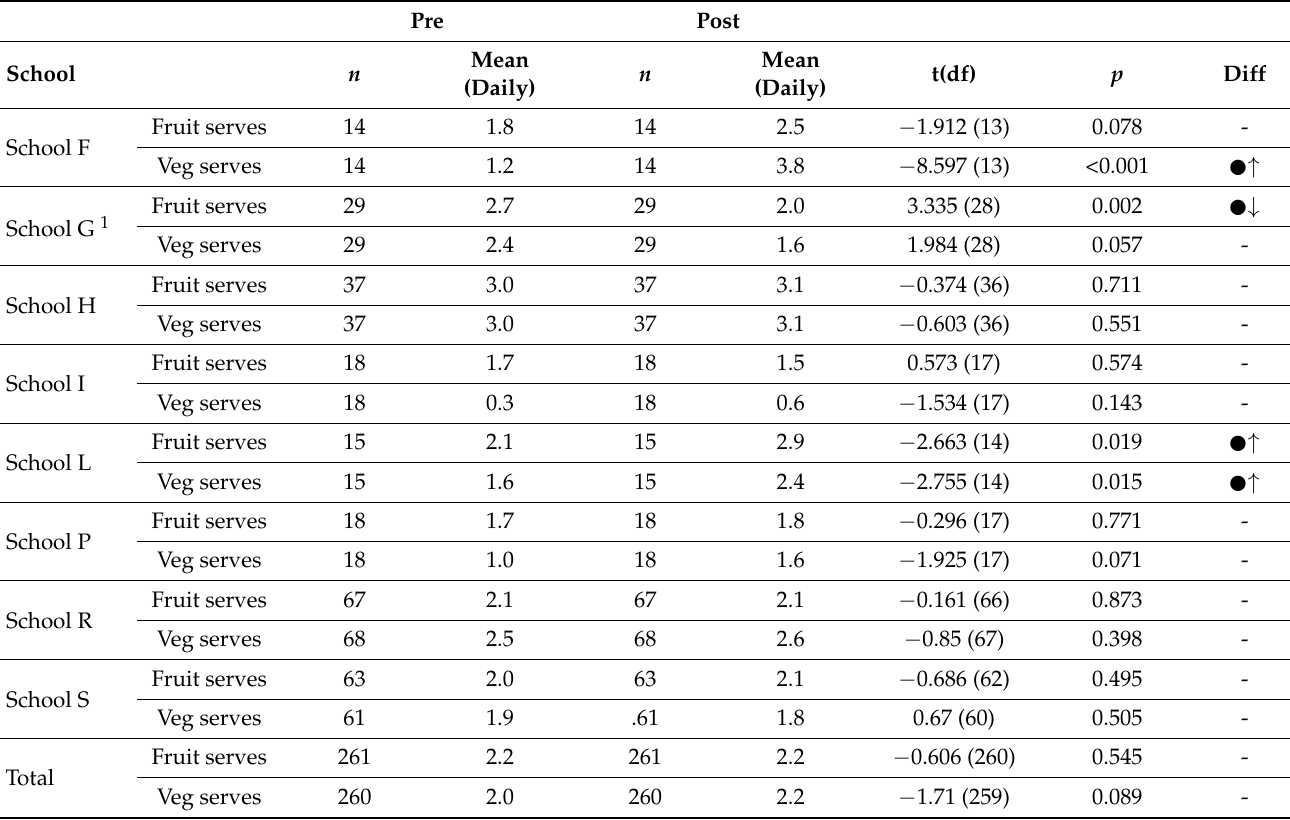
Table 7. Individual level Paired Samples t-Test results—Passport